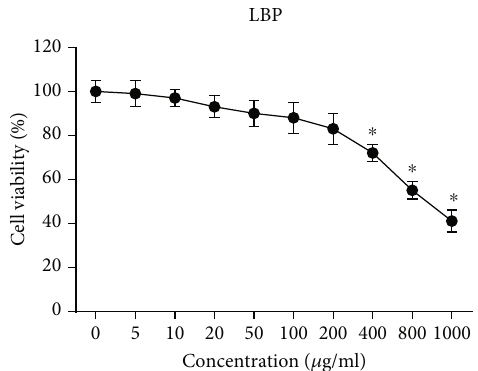
Figure 2: LBP inhibited the viability of A431 cells ( n = 9 ). Compared with the control group, ∗ P < 0 : 01